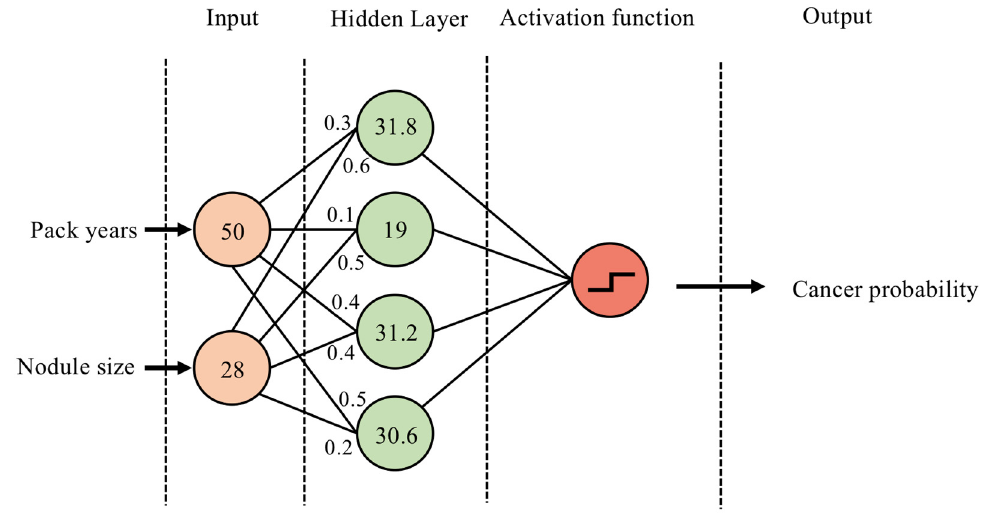
Figure 2. Example of a single-hidden-layer ANN architecture. (1) The smoking status in pack years and lung nodule size (mm) are entered as the two input nodes. (2) In the hidden layer, each node multiplies the values from incoming neurons by a weight (shown as decimals at incoming neurons) and aggregates them. (3) The results are passed to an activation function, converting the output to a probability of cancer between 0 and 1. Multiple learning cycles are used to update the hidden layer weights to improve